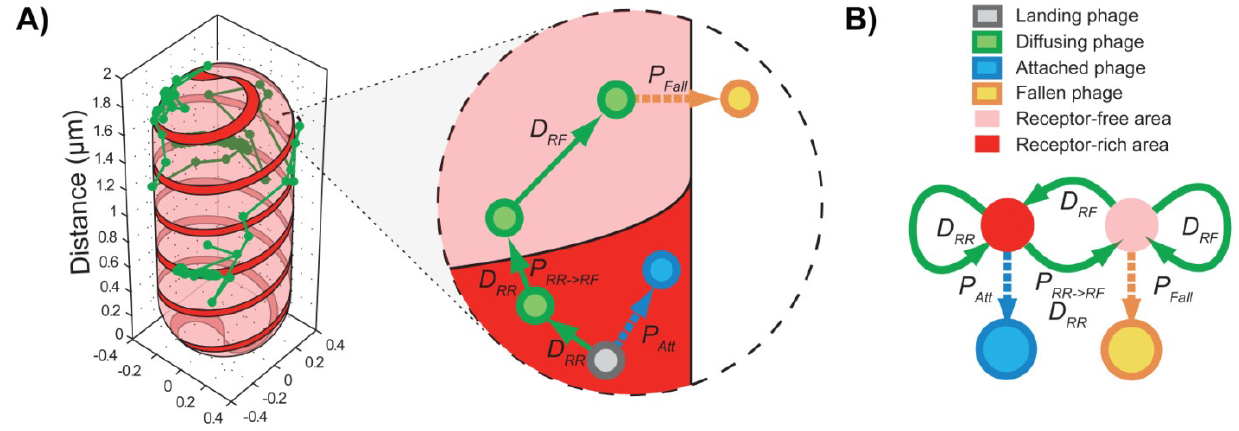
Figure 6. Theoretical model of phage target finding. ( A ) A schematic description of the model, showing a typical phage trajectory (green) on the surface of an E. coli cell. Cell shape was modeled as a cylinder with hemispherical caps (radius R = 0.4 µ m). The cell c surface was divided into receptor- free (transparent pink) and receptor - rich (solid red) areas. The receptors form a 50-nm-thick double helical or multi-ring pattern along the cell surface. The zoomed-in area shows the kinetic scheme in detail. A phage located in a receptor-rich zone can either move within the receptor area with a stepsize consistent with the diffusion coefficient D , become attached with a probability P (chosen to match the RR Att experimentally observed dwell time to attachment), or move into a receptor-free zone. This move can be rejected with a probability 1 − P , in which case the move will be NR → R repeated. On the other hand, a phage located in a receptor-free area can move with a diffusion coefficient D . If the phage attempts to enter the receptor zone, the move will NR always be allowed. The phage can also fall off the cell with a probability P = τ sim/< τ > , where τ is the time step of the simulation and < τ > , is the Fall Fall sim Fall experimentally observed dwell time to fall- off in a LamB - E. coli strain. ( B ) A simplified kinetic scheme of the model, shown as a four-state, discrete-time Markov chain. The nonreceptor (NR) and receptor (R) states are transient, and the attachment (A) and fall -off (F) states are absorbing. ( C ) Generating population heterogeneity. Cell lengths were randomly chosen from a log-normal distribution spanning the experimentally observed cell sizes. The cell size defines the pitch of receptor double helix according to the relationship obtained experimentally. For short cells with helix angles of <10, a multi-ring pattern was used instead of a double helix. ( D ) Representative 2D projections of phage trajectories in normalized units (green lines). The initial landing site is shown as a gray circle. Panels in the first two rows display trajectories ending in attachment (blue circle), and panels i n the last two rows display trajectories ending with the phage falling off the cell (at a position denoted with a yellow circle). Adopted and modified after